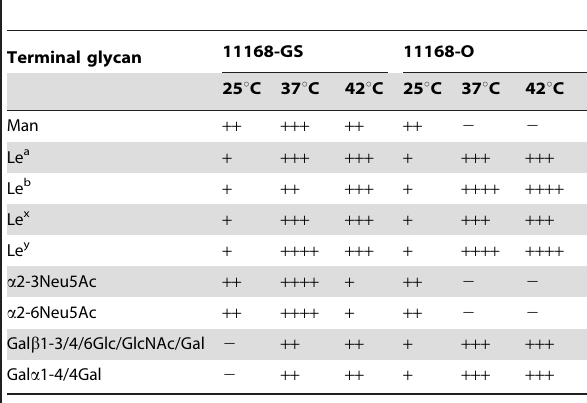
Table 3. Summary of C. jejuni 11168-GS and 11168-O binding to glycan